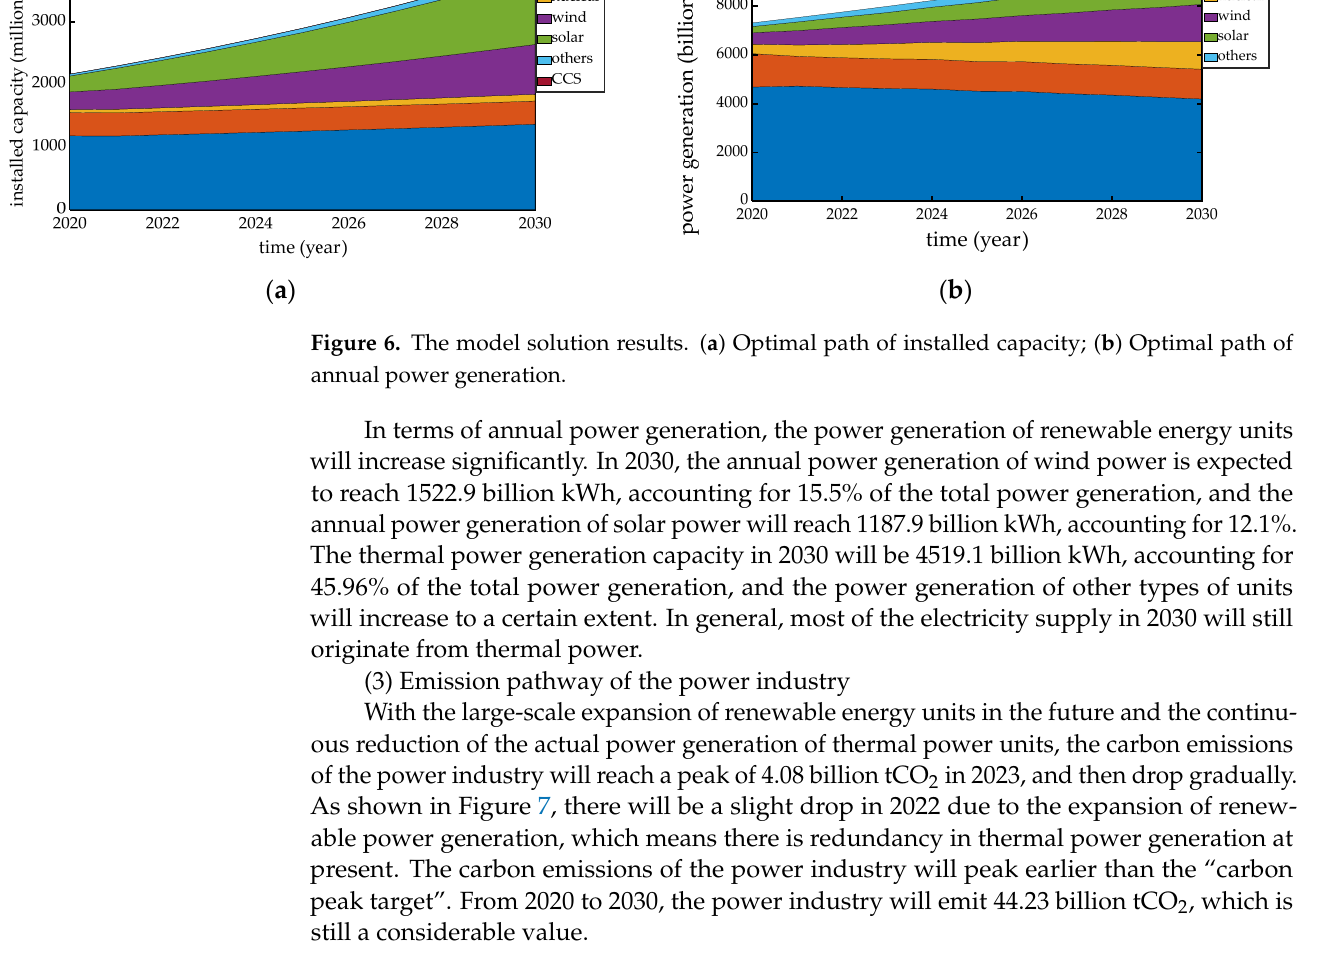
Figure 7. Emission pathway of the power industry .